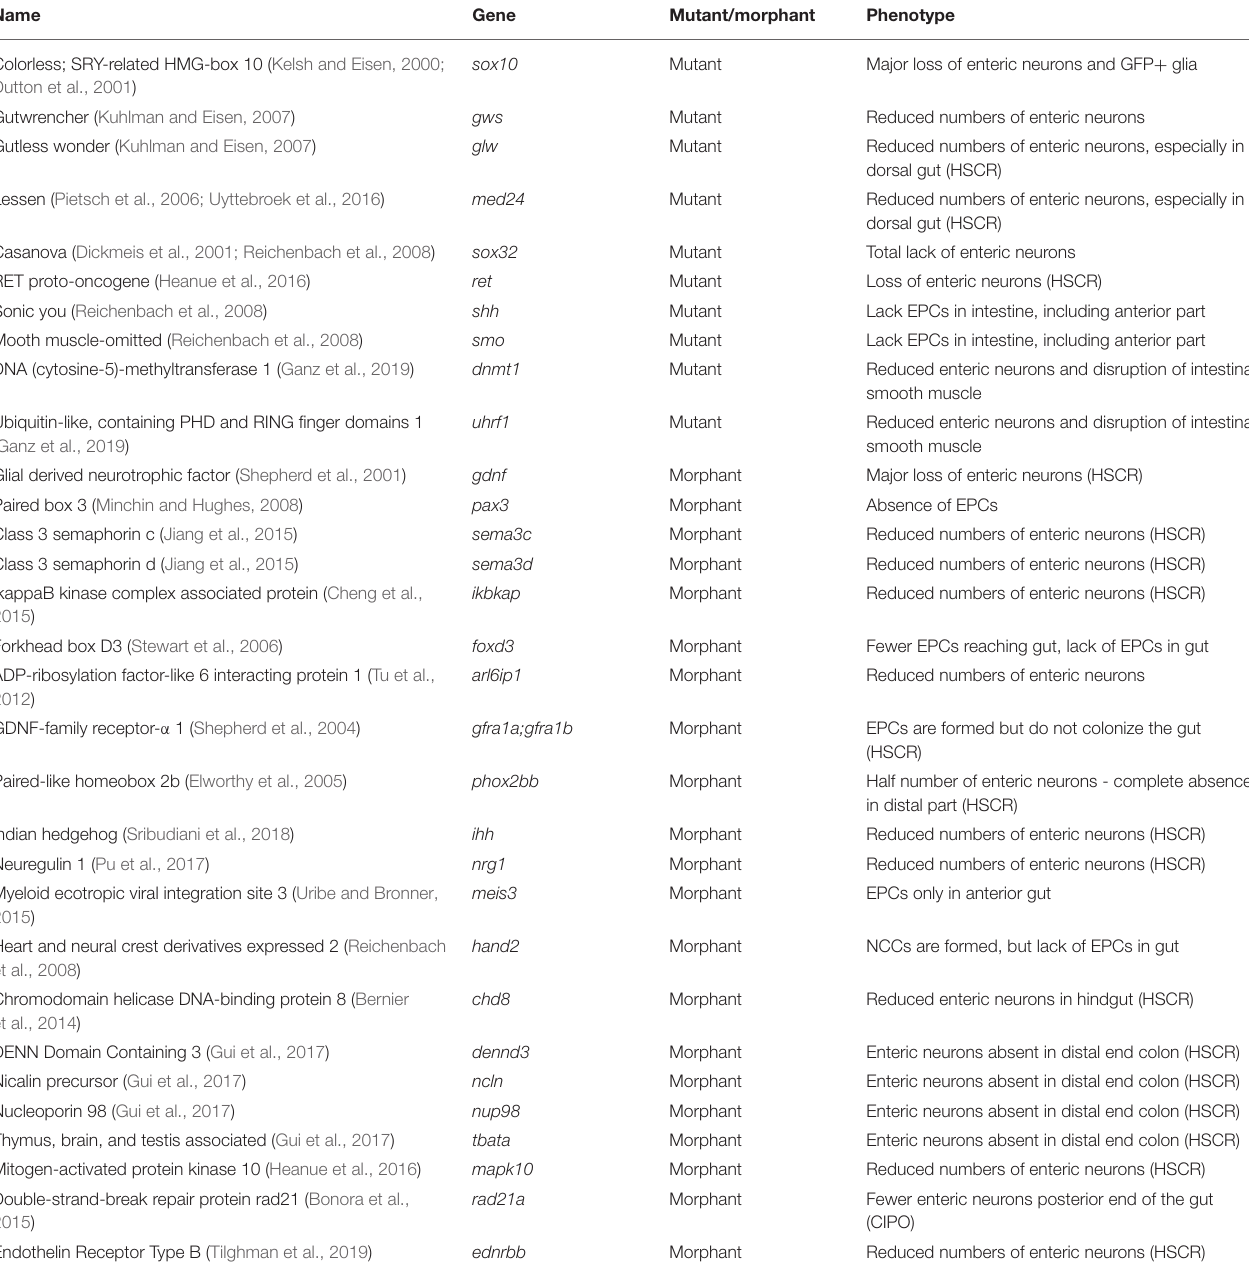
TABLE 1 | Overview of the stable zebrafish mutants and morphants presenting an ENS